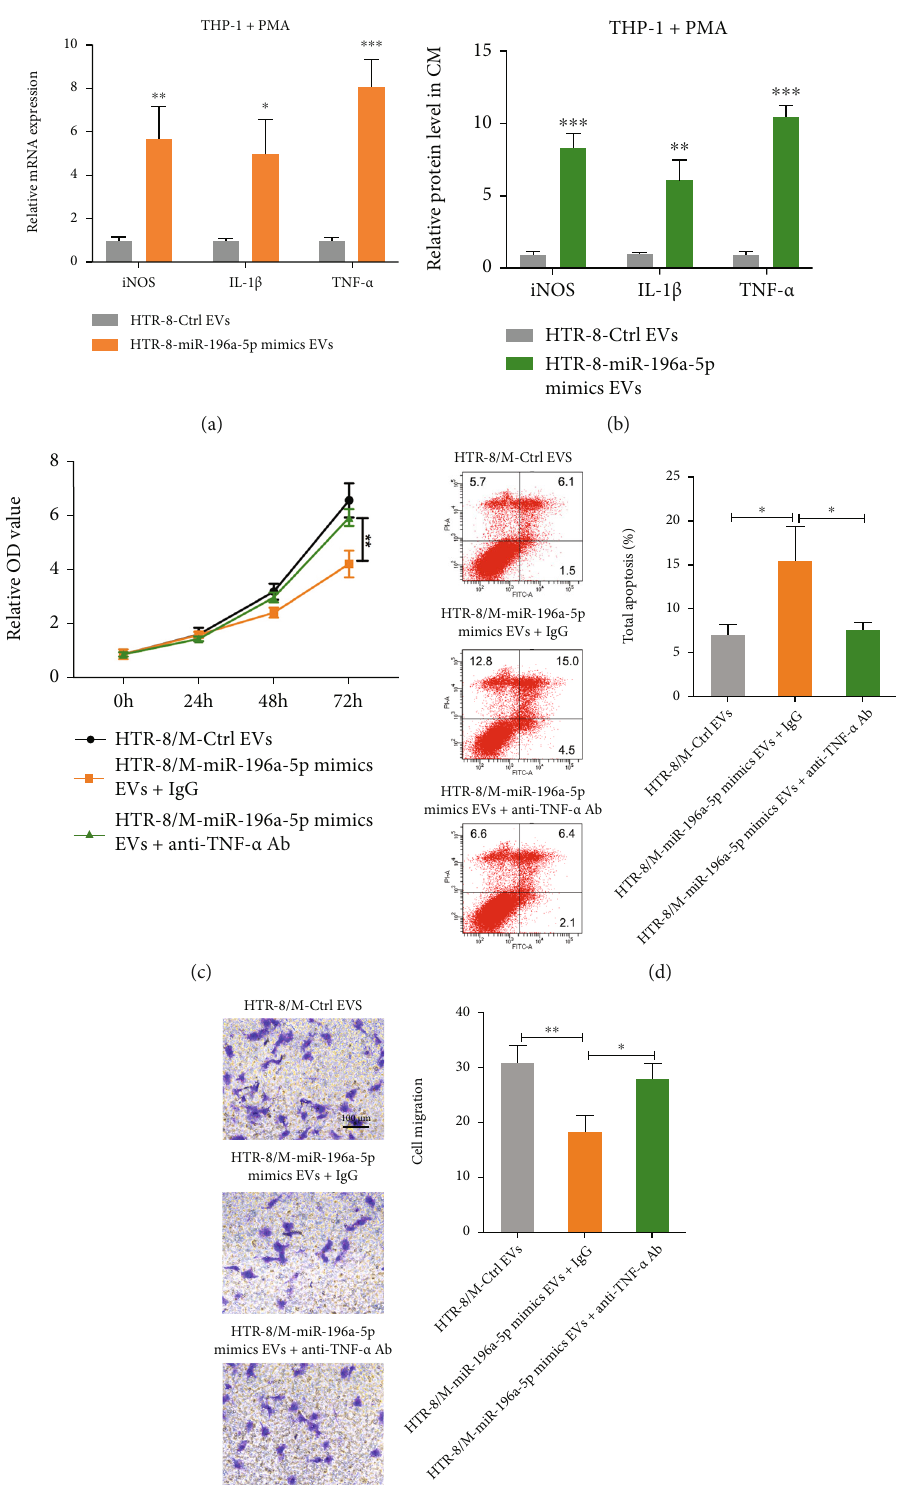
Figure 7: M1 macrophages polarized by EV miR-196a-5p regulate the function of trophoblasts via secretion of TNF- α . (a, b) PMA-pretreated THP-1 cells were treated with EVs derived from miR-196a-5p-overexpressing HTR-8 cells. (a) qPCR and (b) ELISA analysis of the mRNA and protein levels of iNOS, IL-1 β , and TNF- α . (c – e) PMA-pretreated THP-1 cells were treated with EVs derived from miR-196a-5p-overexpressing HTR-8 cells and further cocultured with HTR-8 cells with a TNF- α antibody or IgG control antibody in the culture medium. (c) CCK-8, (d) fl ow cytometry, and (e) Transwell assays were performed to analyze proliferation, apoptosis, and migration of HTR-8 cells. Scale bar, 100 μ m ( ∗ p < 0 : 05 ; ∗∗ p < 0 : 01 ; ∗∗∗ p < 0 : 001 ). EV: extracellular vesicle; PMA: phorbol 12-myristate